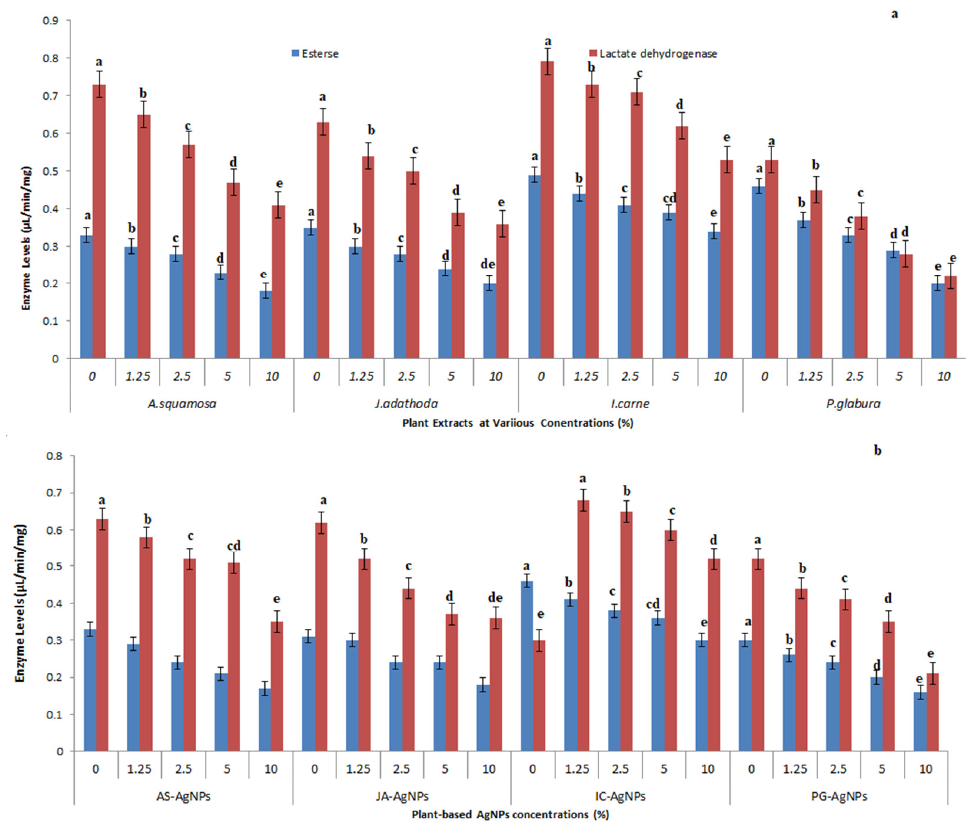
Figure 4. Whole insect body detoxification enzyme esterase and lactate dehydrogenase levels of insect P. solenopsis exposed to P. glabura , I. carnea , A. squamosa , and J. adathoda ( a ) and AS- AgNPs, JA- AgNPs, IC- AgNPs, and PG -AgNPs ( b ) at different concentrations. Different letters (among the same concentration for each enzyme separately) above bars indicate significantly different